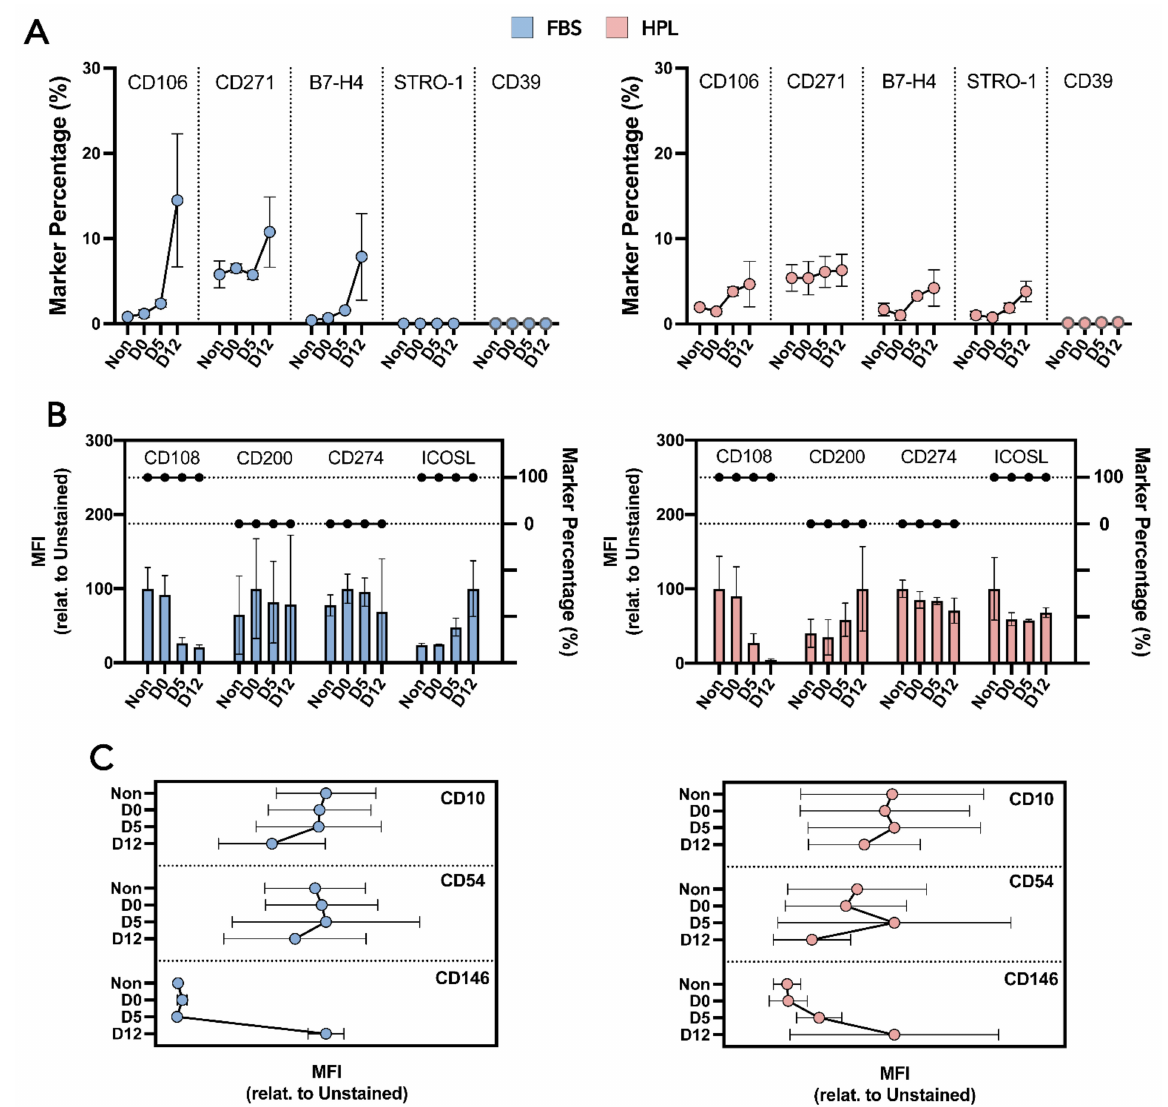
Figure 4. Characterization of MSC(AT) immunosuppression potential and clonogenic ability. ( A ) Sub- population immunosuppressive and clonogenic marker expressions for MSC-FBS ( left ) and MSC-HPL ( right ). ( B ) Homogeneous immunosuppressive and clonogenic populations with marker percentage and median fluorescence intensity (MFI) levels for MSC-FBS ( left ) and MSC-HPL ( right ). The inter- connected dots are the marker percentage and the bars are the MFI. ( C ) MFI analysis for motility (CD10), translocation (CD54), and hematopoietic support-related (CD146) markers for MSC-FBS ( left ) and MSC-HPL ( right ). Non—non-encapsulated; three MSC(AT) donors; mean ± SEM. MSC(AT) preserved their identity during encapsulation as a homogeneous popula- tion for the set of markers analyzed. For MSC-FBS and MSC-HPL, numerous functional branches were explored and shown to be stable during storage at hypothermic